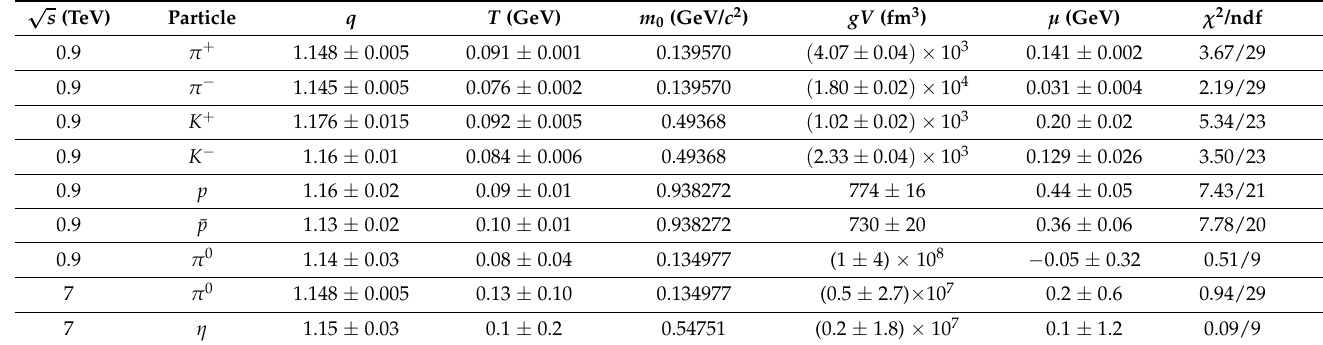
Table 1. Best-fit parameters of the Cleymans Formula (1). The data represent proton-proton collisions √ s = 0.9 and 7 TeV from Refs. [27,28]. The particle masses are taken at the center-of-mass energies, from [29]. In the last column, the χ 2 -statistics values are given per the number of degrees of freedom ( ndf ).